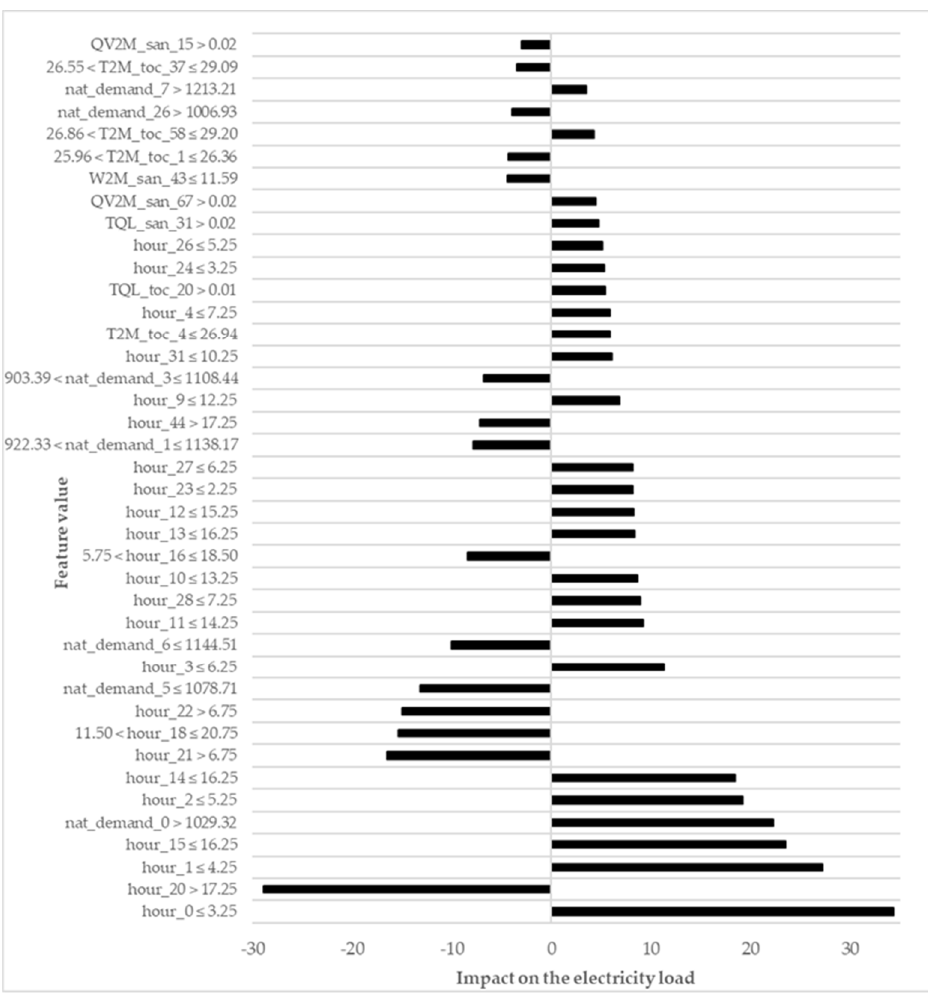
Figure 3. Explanations for the prediction of the electricity load in experiment 1.